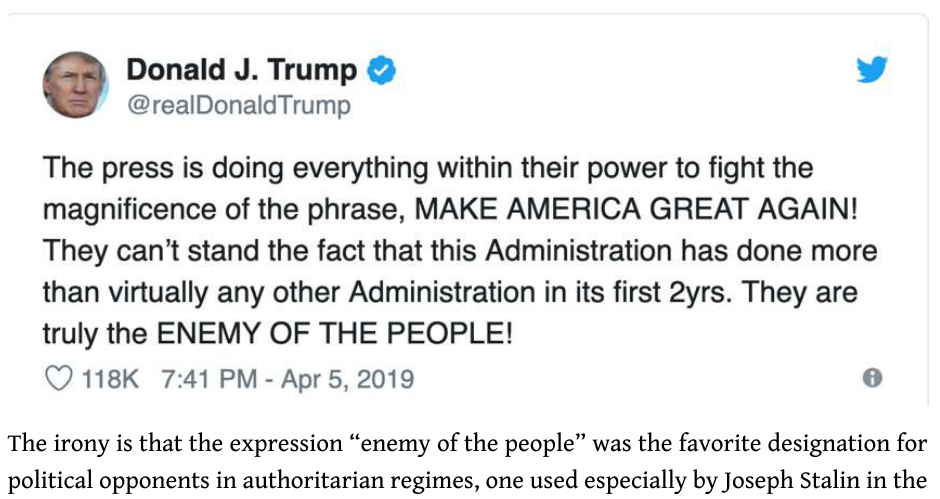
Figure 3. Tweet by Donald Trump attacking the press as “Enemy of the people” on April 5,